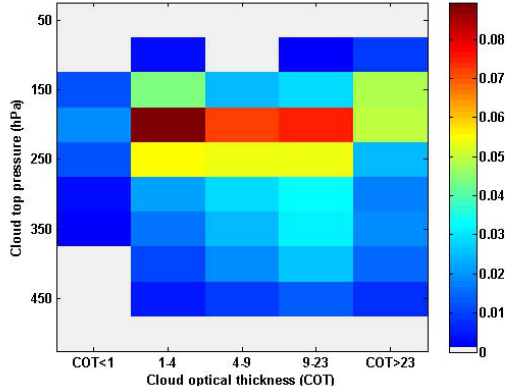
Fig. 6. The 2-D histogram of cloud optical thickness and cloud top pressure from the MODIS data for June, July, August and Septem- ber months from 2003 to 2008. The histogram is normalized by the total number of cloudy pixels in the study area (i.e. 0–40N, 60– 100E).